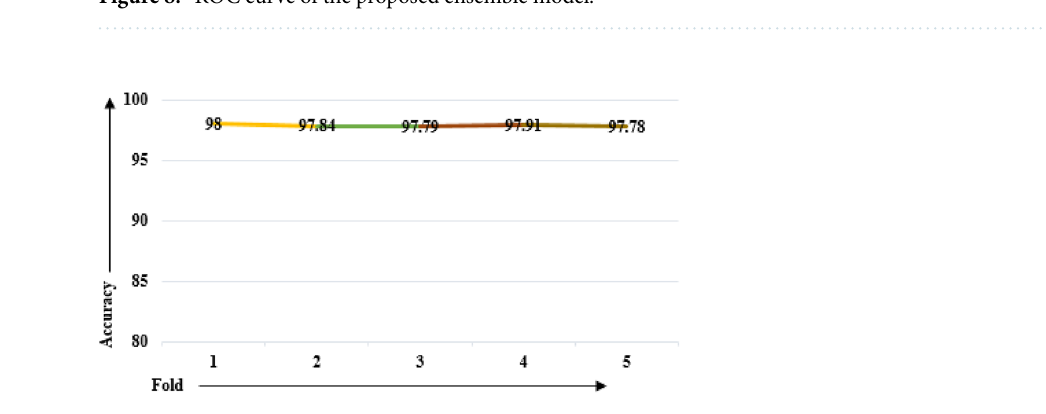
Figure 8. ROC curve of the proposed ensemble model.